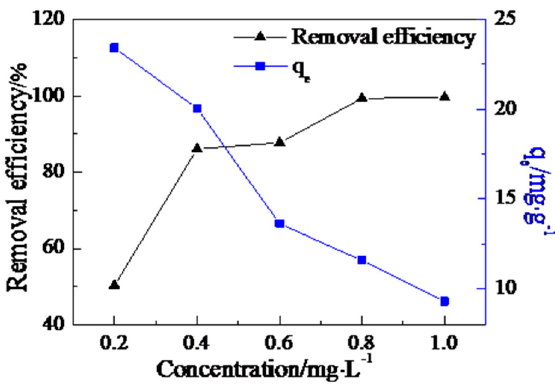
Figure 3. The effect of MPy-600 concentration on the adsorption of Hg(II).